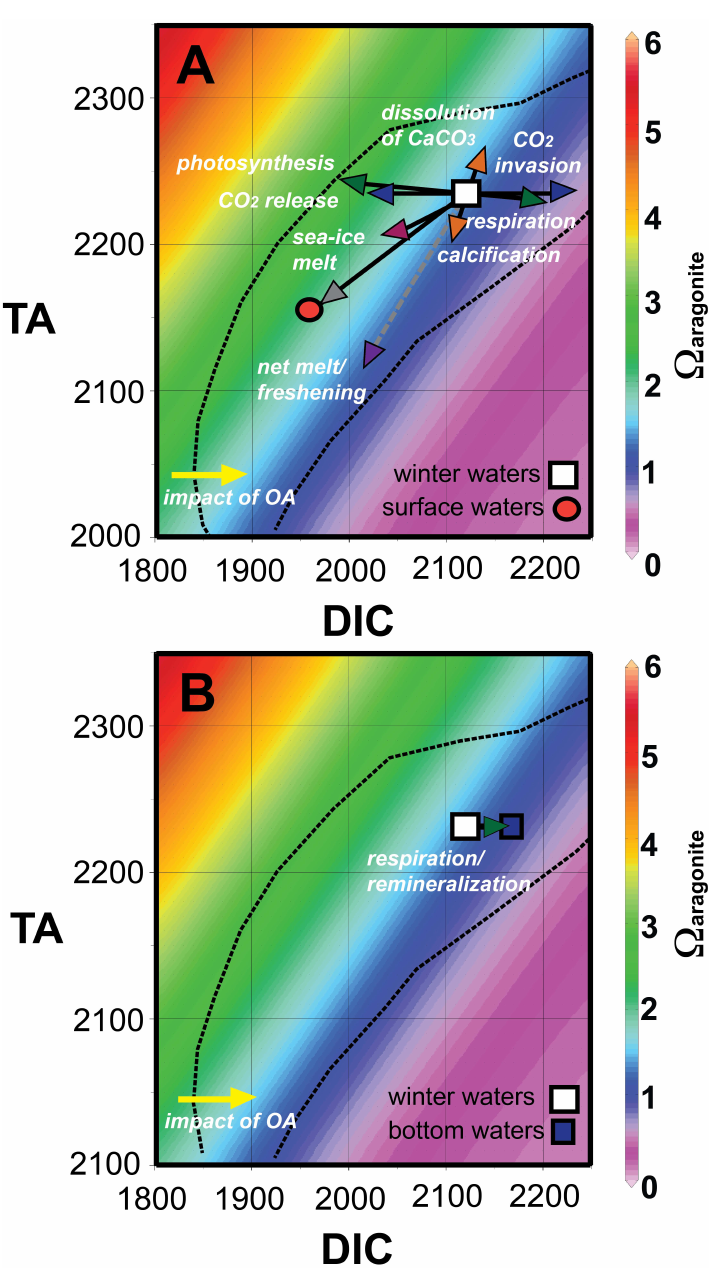
Fig. 9. Contour plot of (cid:127) aragonite variability for a range of DIC and TA values observed in the western Arctic Ocean (primarily Chukchi Sea but also eastern East Siberian Sea and western Beaufort Sea) with the relative direction of changes imparted by the dominant physico- biogeochemical drivers in the region (shown by arrows). Nearly all RUSALCA/ICESCAPE (cid:127) aragonite data fall within the dashed line shown (surface waters, A , and subsurface seasonal changes, B ). The directions of (cid:127) aragonite change imparted by physico-biogeochemical processes are shown for “typical” spring shelf water (TA = 2200µmolkg − 1 ; DIC = 2000µmolkg − 1 ; salinity = 33; temperature =− 1 ◦ C) with the caveat that the direction of (cid:127) aragonite change will alter slightly depending on the starting point of seawater carbonate chemistry. (cid:127) aragonite changes are shown in Fig. 7, but (cid:127) calcite changes could be similarly shown also. Another important caveat is that the plot of (cid:127) against DIC and TA does not show all of the changes imparted by physico-biogeochemical processes (e.g., temperature and changes in CaCO 3 solubility with ionic strength), but these exceptions are discussed in the paper. The arrows denote direction of (cid:127) change due to individual/combined processes, but arrow length does not denote magnitude of (cid:127) change. Photosynthesis, primary production and loss of CO 2 from surface waters due to gas exchange increase (cid:127) . Calcification/dissolution of CaCO 3 , warming and cooling, and freshening of the mixed layer have minor impact on (cid:127) . Respiration, remineralization of organic carbon to CO 2 and gain of CO 2 by surface waters due to gas exchange decrease (cid:127)